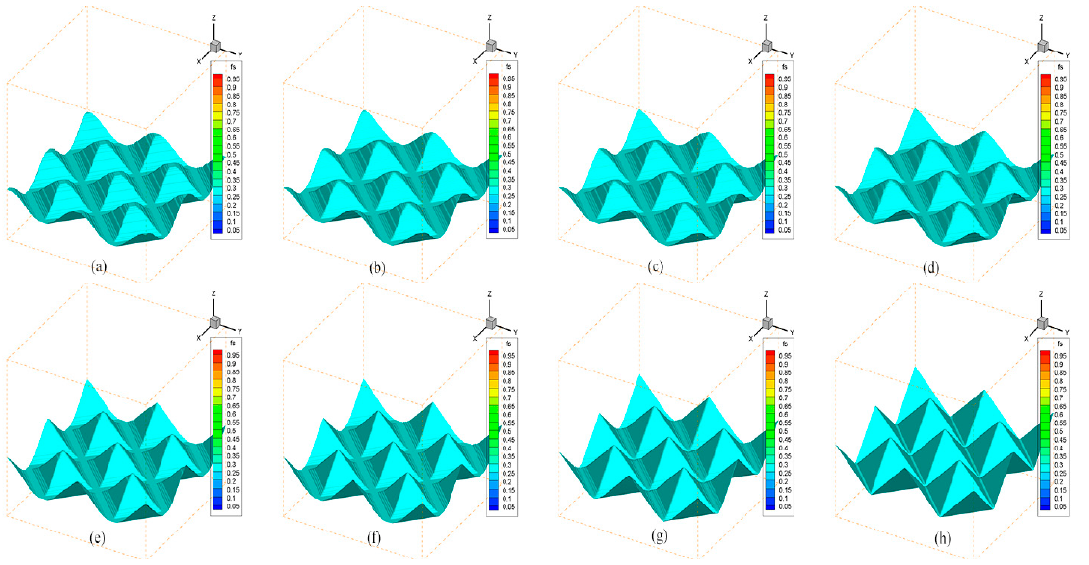
Figure 5. Growth morphology of solid phase ratio of each 200 time steps: ( a )–( h ).